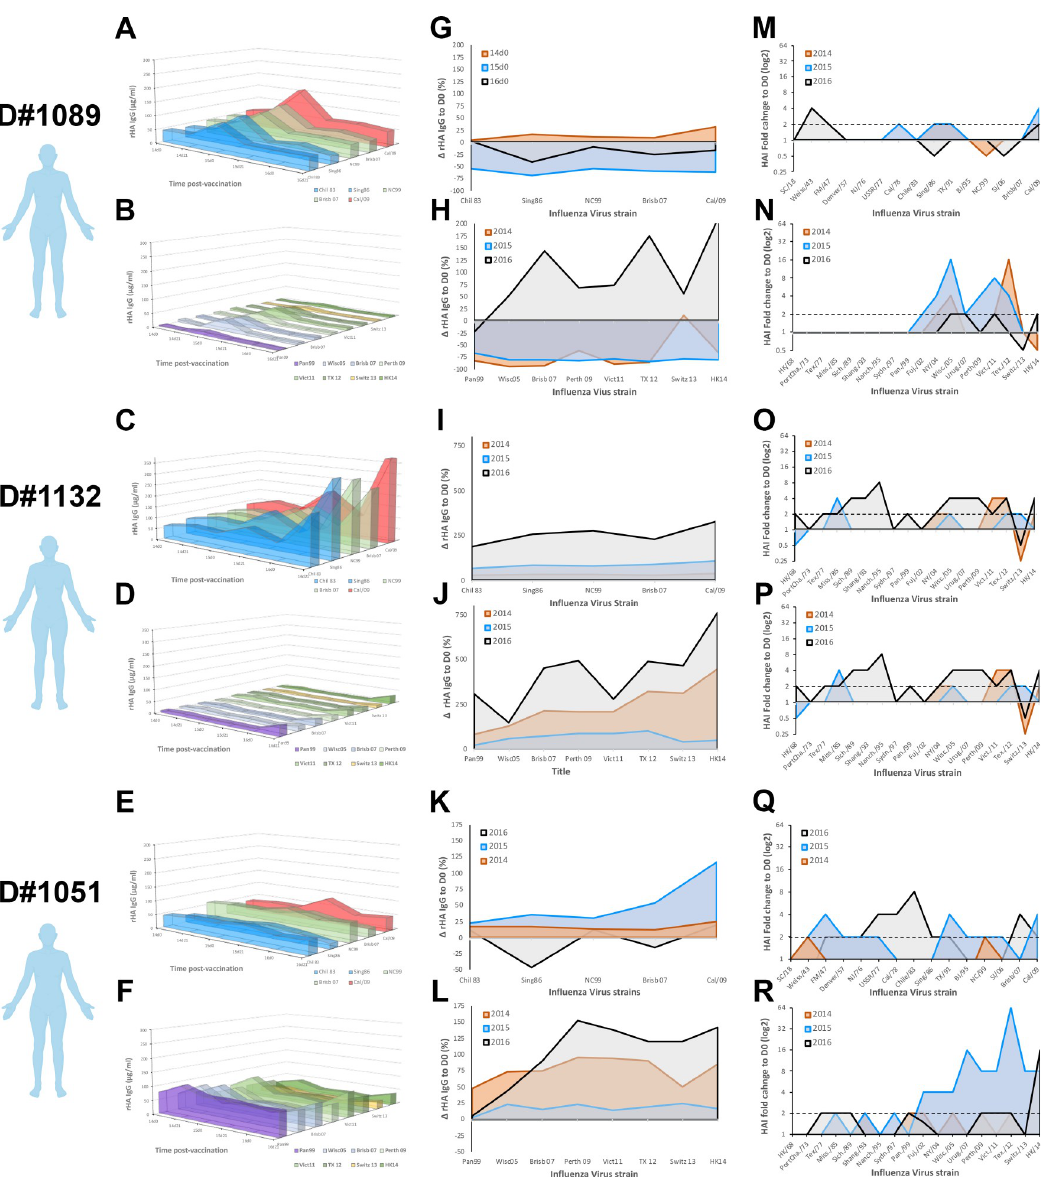
Fig 5. Serological antibody landscape in elderly participants vaccinated for three consecutive years. A,C,E) Serological IgG antibodies against rHA from current H1N1 vaccine strain and 4 historical seasonal H1N1 virus strains (1983–2007) in three elderly participants vaccinated for three consecutive years. Colors represent antigenically similarity between H1 rHA. B,D,F) Serological IgG antibody levels against rHA the current H3N2 vaccine strains and 5 historical seasonal H3N2 virus strains (1999–2011) in three elderly participants vaccinated for three consecutive years. Colors represent antigenically similarity between H3 rHA. G,I,K) Changes in serological antibody levels against rHA from different H1N1 virus strains, measured as in A, 21–28 days after vaccination in elderly participants vaccinated for three consecutive years. H,J,L) Changes in serological antibody levels against rHA from different H3N2 virus strains, measured as in B, 21–28 days after vaccination in elderly participants vaccinated for three consecutive years. M,O,Q) Changes in serological HAI activity titer against different H1N1 virus strains (1918–2009) 21–28 days after vaccination in elderly participants vaccinated for three consecutive years. N,P,R) Changes in serological HAI activity titer against different H3N2 virus strains (1968–2016) 21–28 days after vaccination in elderly participants vaccinated for three consecutive years.